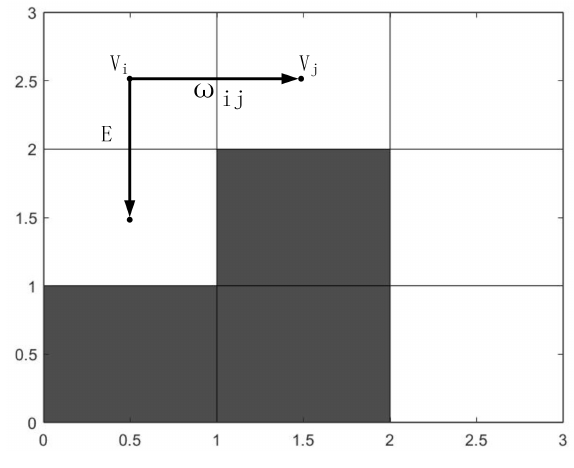
Figure 2. Weighted directed graph based on grid graph. Table 1. Parameters in the formula and their corresponding meanings. Parameters Meaning of